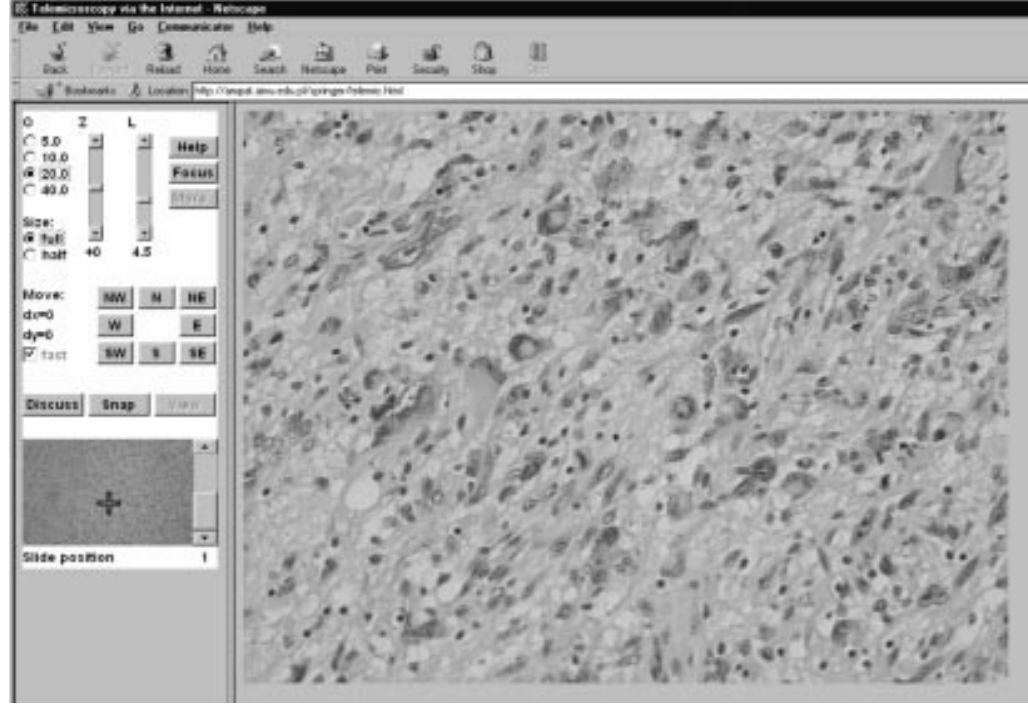
Fig. 2. User’s interface of TELEMIC system for the display of virtual slide with visible area of interest at the higher